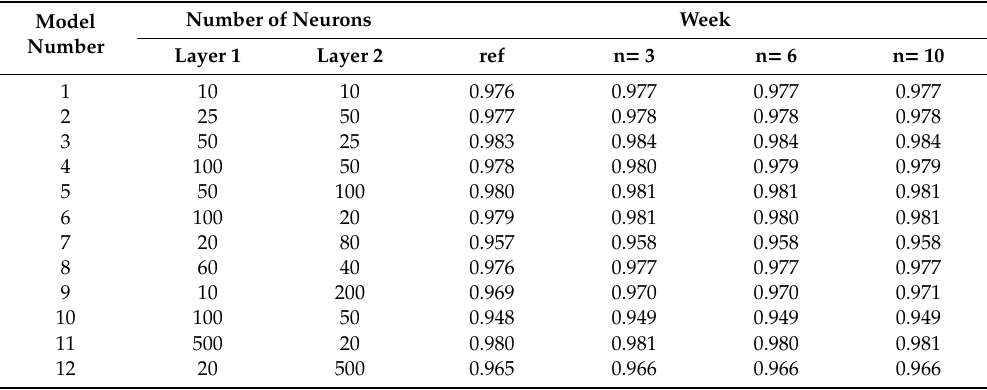
Table 11. Correlation analysis for the reference signals and wavelet-based